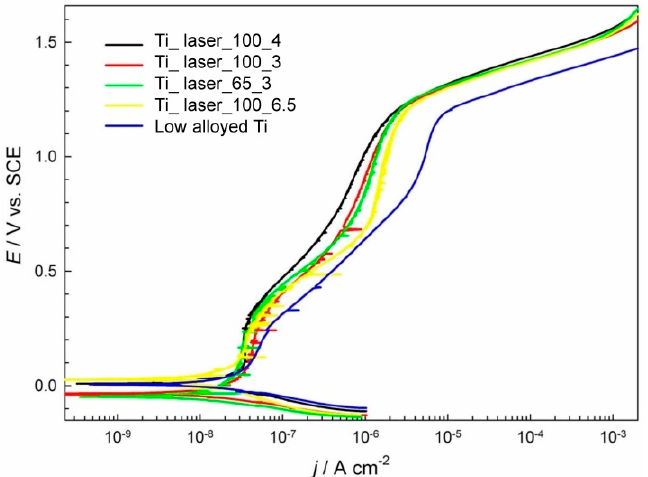
Figure 3. Potentiodynamic polarisation curves for Ti and laser treated Ti surfaces in 0.1 M NaCl solution at a scan rate of 1 mV/s. Table 3. Electrochemical parameters from potentiodynamic curves.